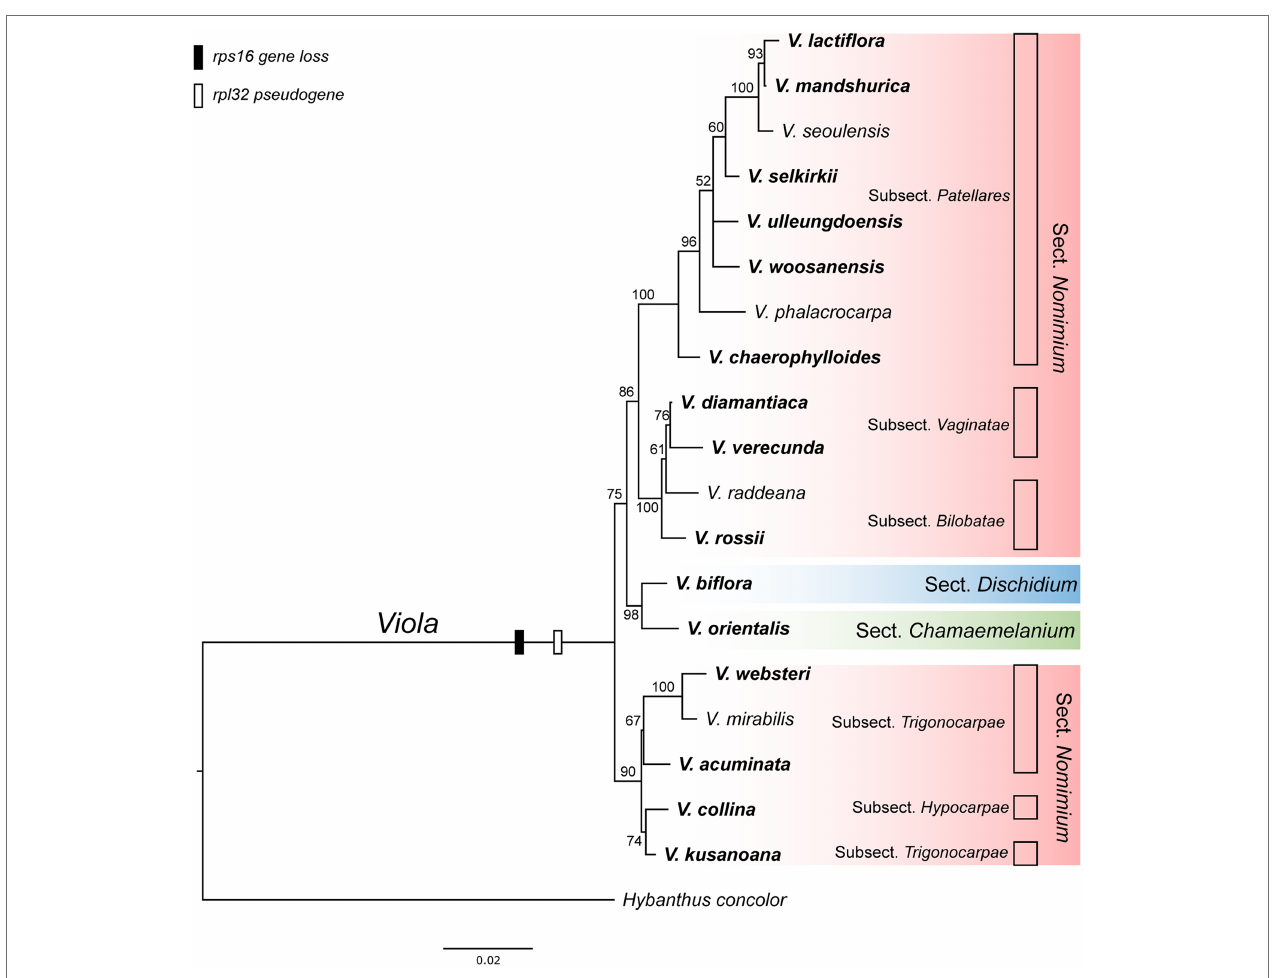
FIGURE 5 | Phylogenetic distribution of plastid-encoded rpl32 and rps16 gene loss events in 19 representative species of the family Violaceae. The bootstrap value based on 1,000 replicates and >50% are shown for each